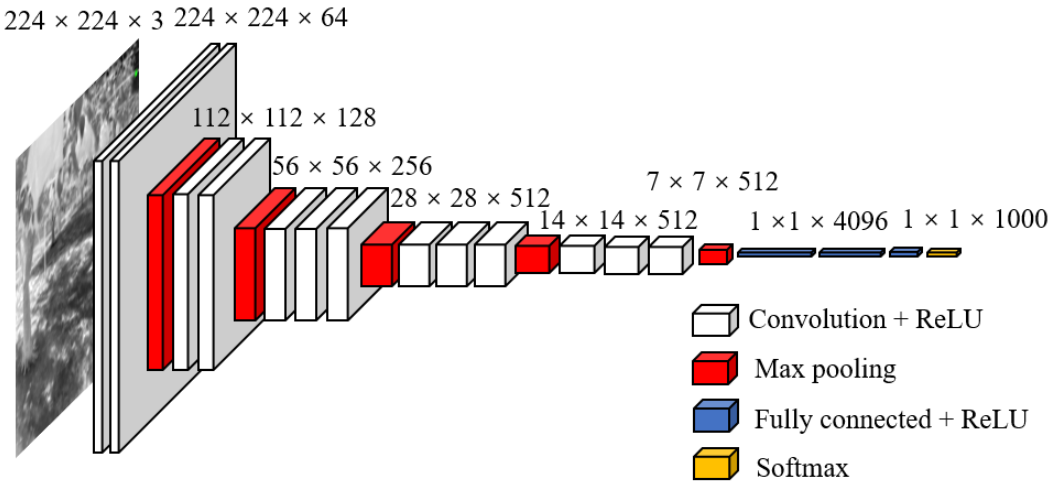
Figure 6. VGG16 for target of tree trunk